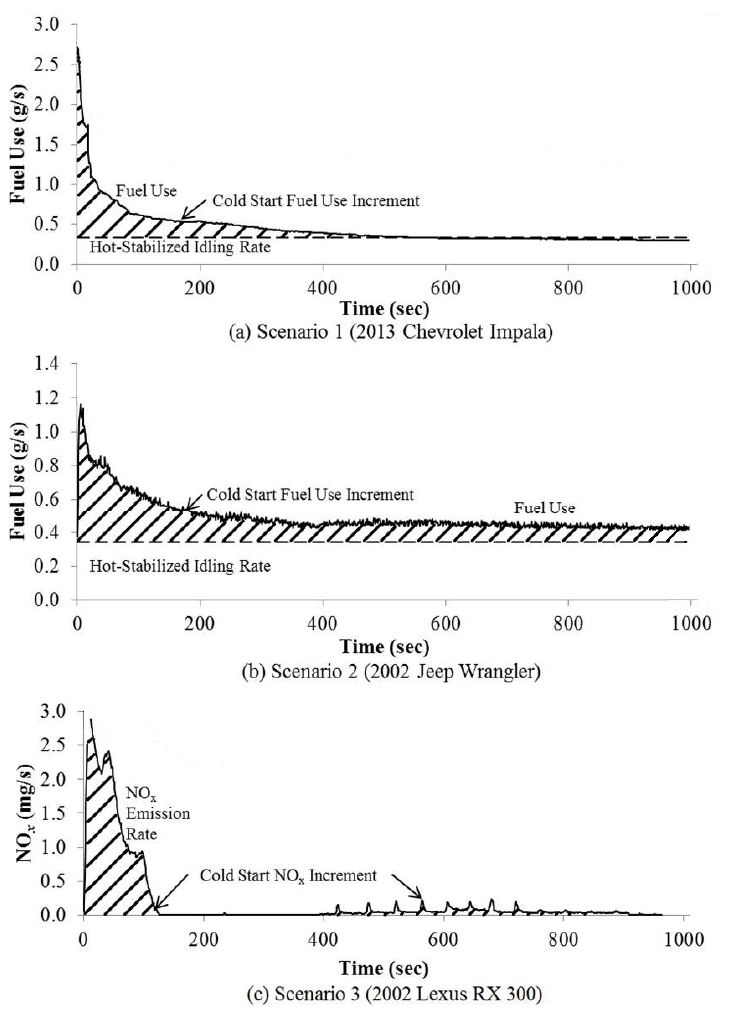
Figure 4. Scenarios for idle cold start quantification: ( a ) Scenario 1—Approach to Hot Stabilization (example for 2013 Chevrolet Impala); ( b ) Scenario 2—Approach to Steady State (example for 2002 Jeep Wrangler); and ( c ) Scenario 3—Secondary Peaks (example for 2002 Lexus RX300).